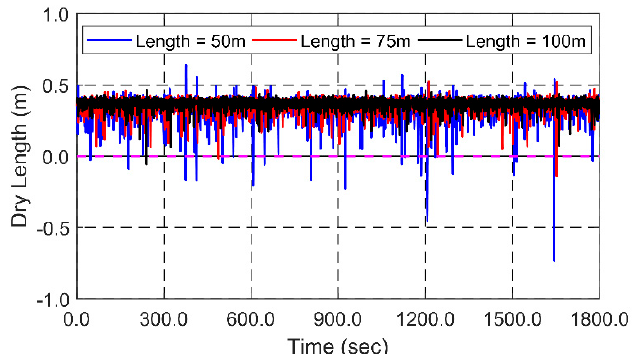
Figure 11. Time histories of the dry length of the location buoy in the middle location for H s = 2.0 m, T p = 7.0 s, and current velocity = 0.6 m/s (the pink line is a reference level which the dry length should be higher than to prevent the buoy from being fully